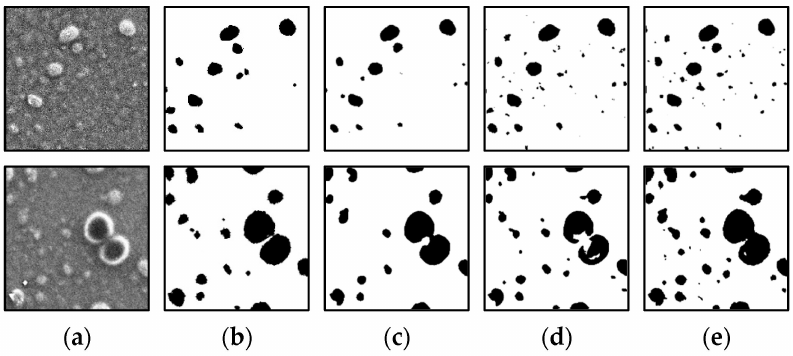
Figure 8. Results of image processing after segmentation (small number of particles). ( a ) Input data; ( b ) Output data (ground truth). Results obtained using ( c ) conventional U-Net; ( d ) U-Net #1; ( e ) U-Net #2.